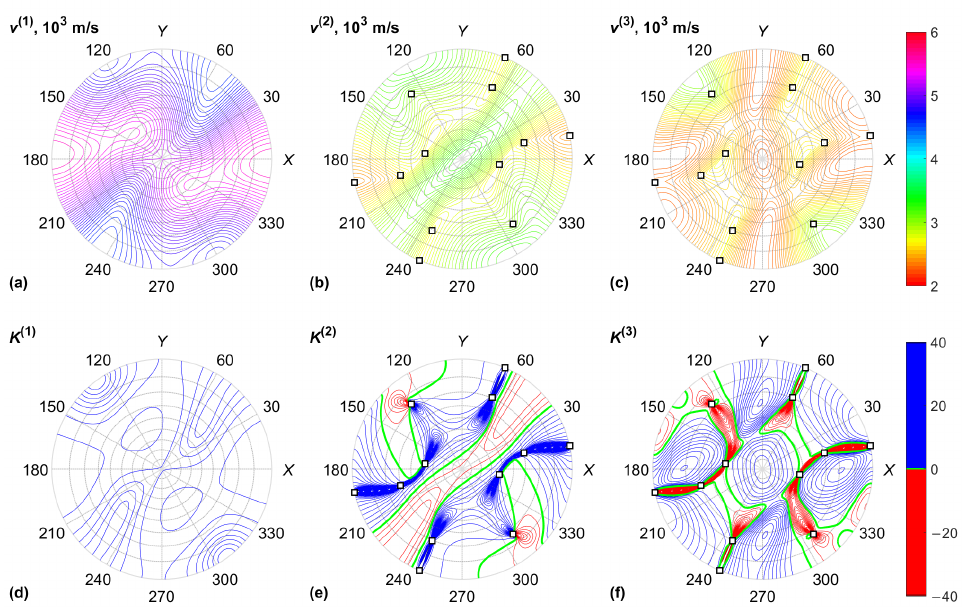
Figure 5. KYW crystal, acoustic properties: ( a ) QL BAW mode velocity; ( b ) fast QS BAW mode velocity; ( c ) slow QS BAW mode velocity; ( d ) QL BAW diffraction coefficient; ( e ) fast QS BAW diffraction coefficient; ( f ) slow QS BAW diffraction coefficient. Conical acoustic axes of the crystal are marked with squares.